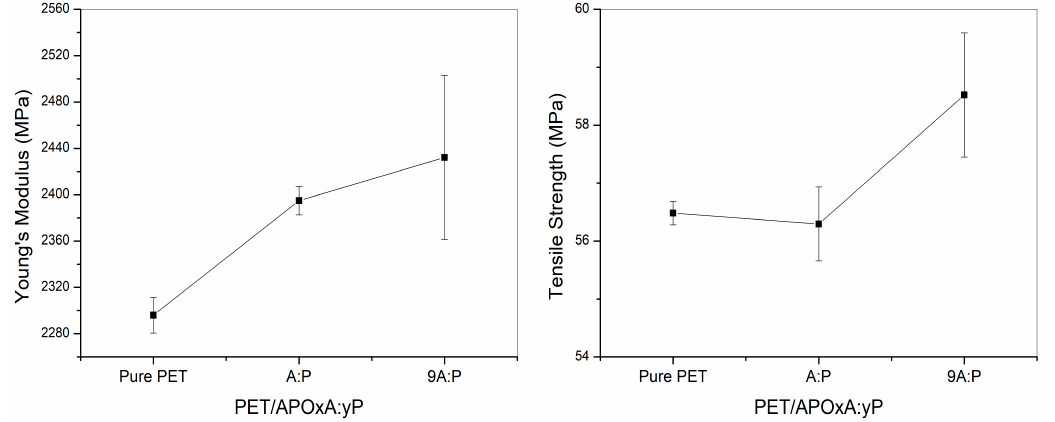
Figure 7. Young’s modulus curves and tensile strength of pure PET and PET hybrids containing 1% by weight of clays APOA:P and APO9A:P.